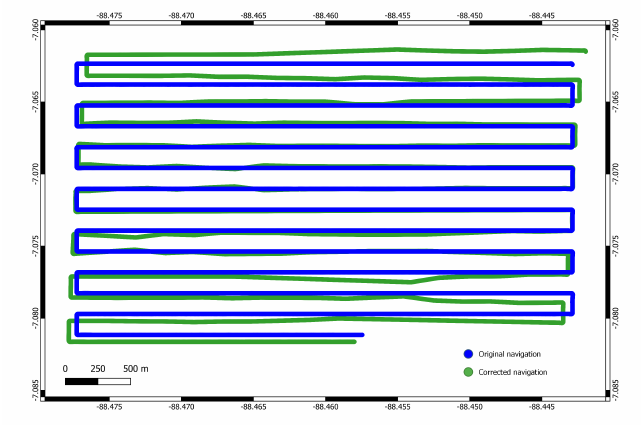
Figure 12. Original navigation and corrected navigation. Naturally the original navigation solution is much more closer to the planned mission, a regular lawn-mowing pattern, the corrected solution shows some significant